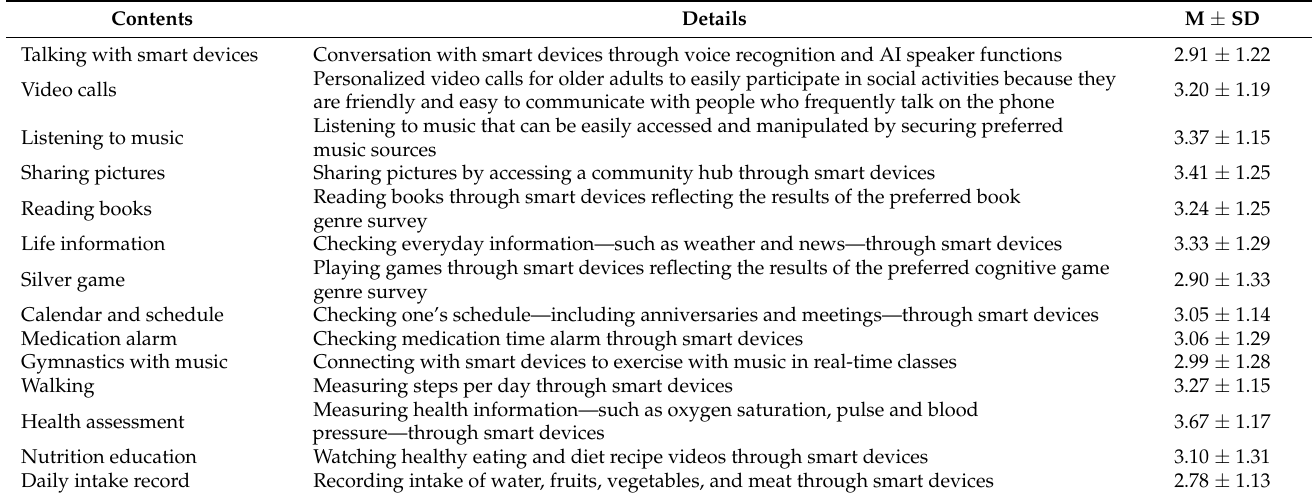
Table 3. Preference for non-face-to-face service components (N =